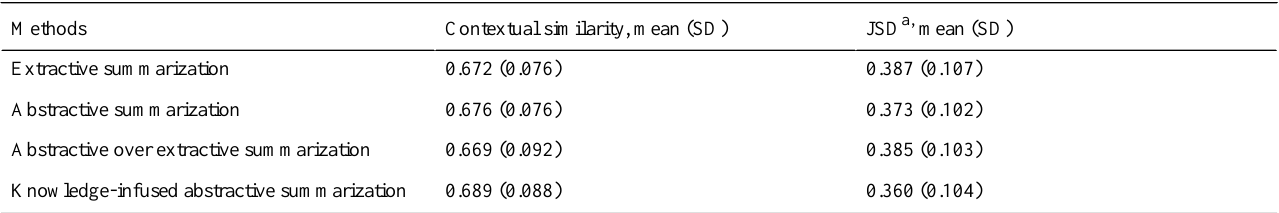
Table 2. Evaluating contextual similarity (higher is better) and information entropy (lower is better) of summaries generated from four different summarization approaches. The reported scores are mean and standard deviation calculated across 184 patient conversations in the Distress Analysis Interview Corpus-Wizard of Oz data